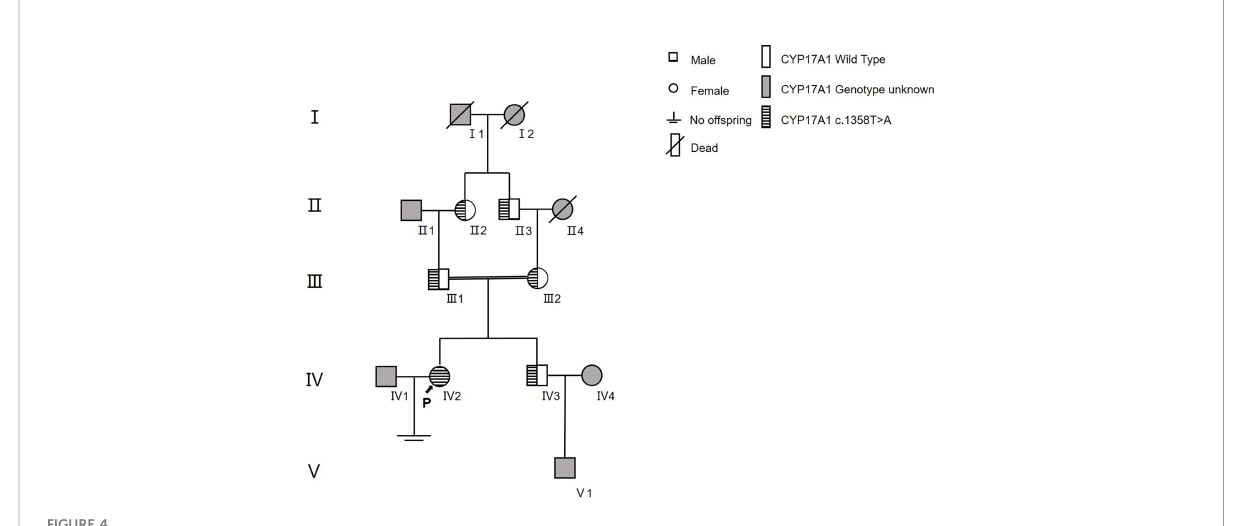
FIGURE 4 The family tree of proband